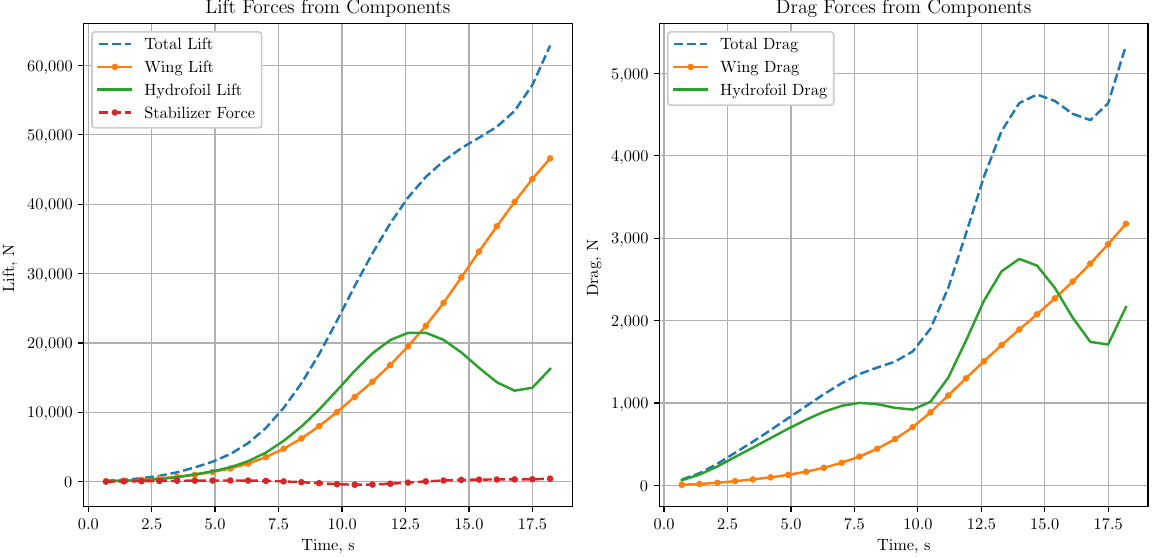
Figure 18. Lift and drag forces of components during water-takeoff process.